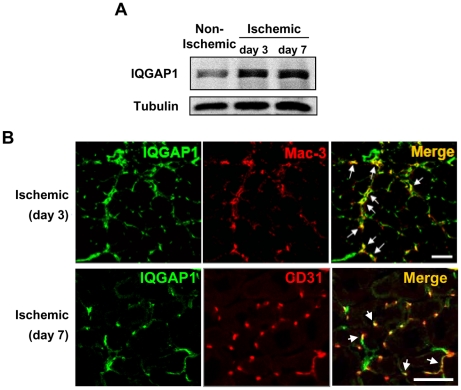
IQGAP1 expression is increased at macrophages and endothelial cells in ischemic hindlimbs.
A, Representative Western blots for IQGAP1 or α-tubulin in adductor muscle at day 0, 3, and 7 after hindlimb ischemia. B, Representative staining for IQGAP1 (green) or Mac-3, macrophage marker (red) or their colocalization (merge) on day 3, and IQGAP1 (green) or CD31, EC marker (red) or their colocalization (merge) on day 7 in ischemic adductor muscles. Arrows represent colocalization with IQGAP1/Mac-3 or IQGAP1/CD31. Bars represent 100 µm.